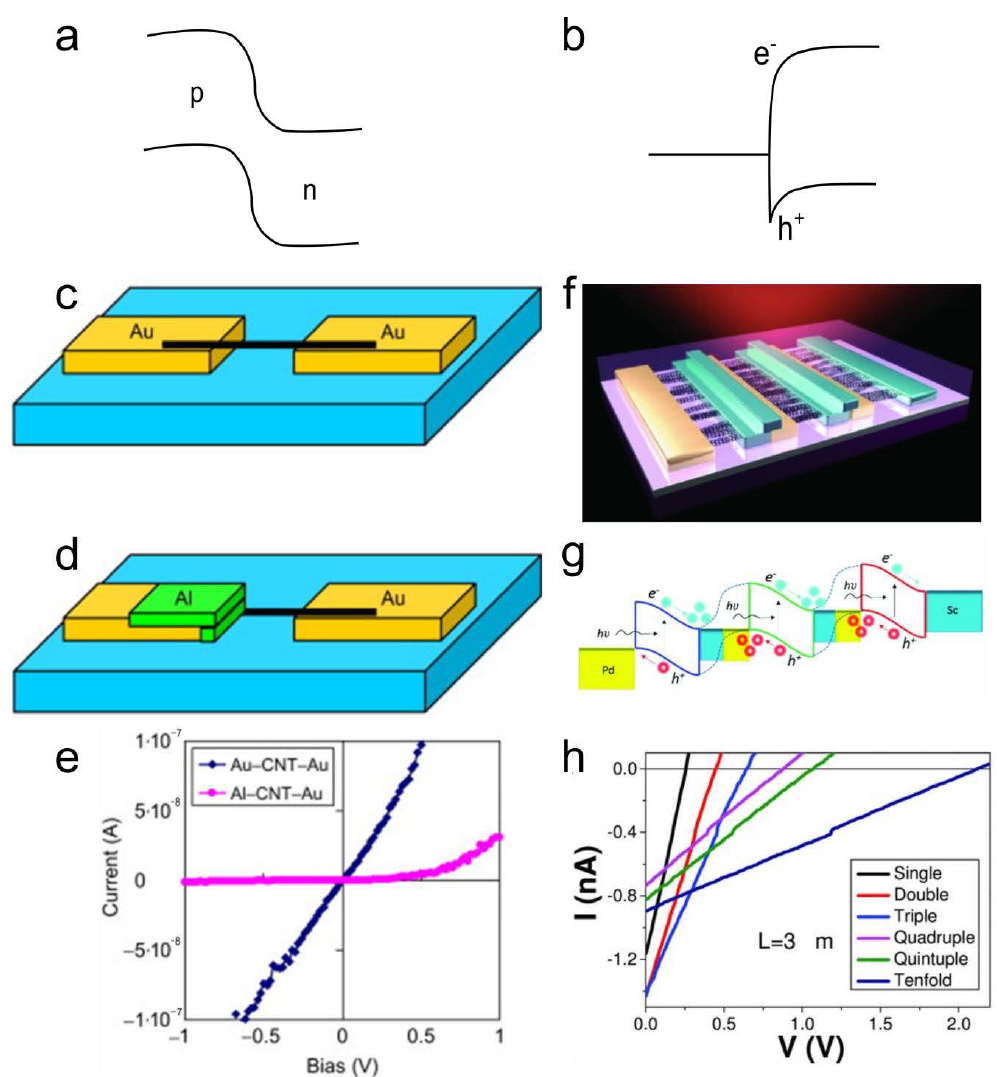
Figure 5. ( a , b ) Sketch of a p-n junction ( a ) and a Schottky junction ( b ). ( c – e ) Fabrication process